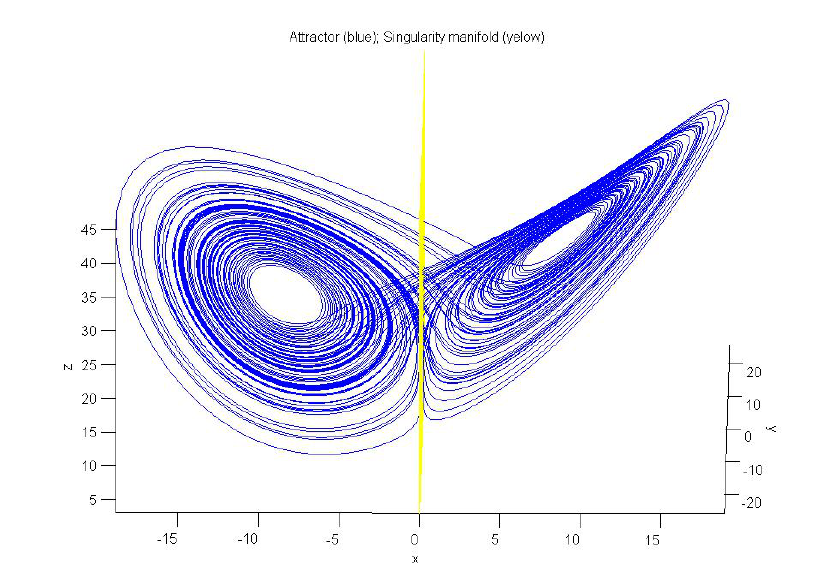
x is selected as output. O (yellow) when